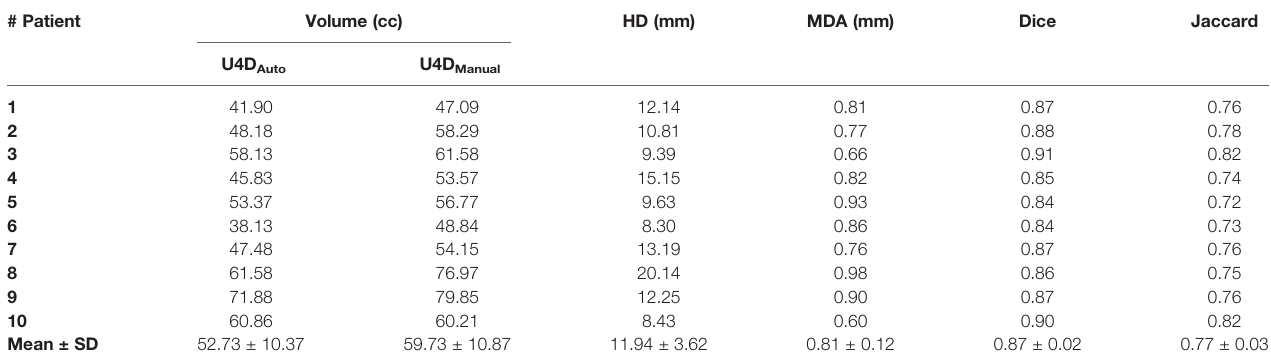
TABLE 1 | Volume, HD, MDA, Dice and Jaccard coef fi cient of U4D Auto and U4D Manual for 10 patients. # Patient Volume (cc) HD (mm) MDA (mm) Dice Jaccard